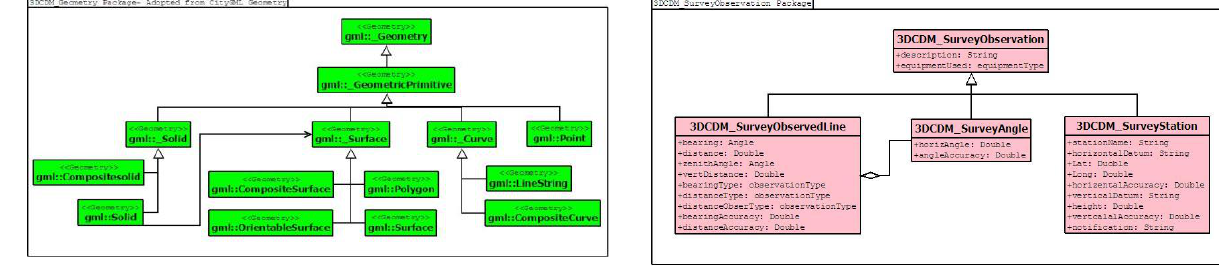
Figure 13. 3DCDM_SurveyObservation Package